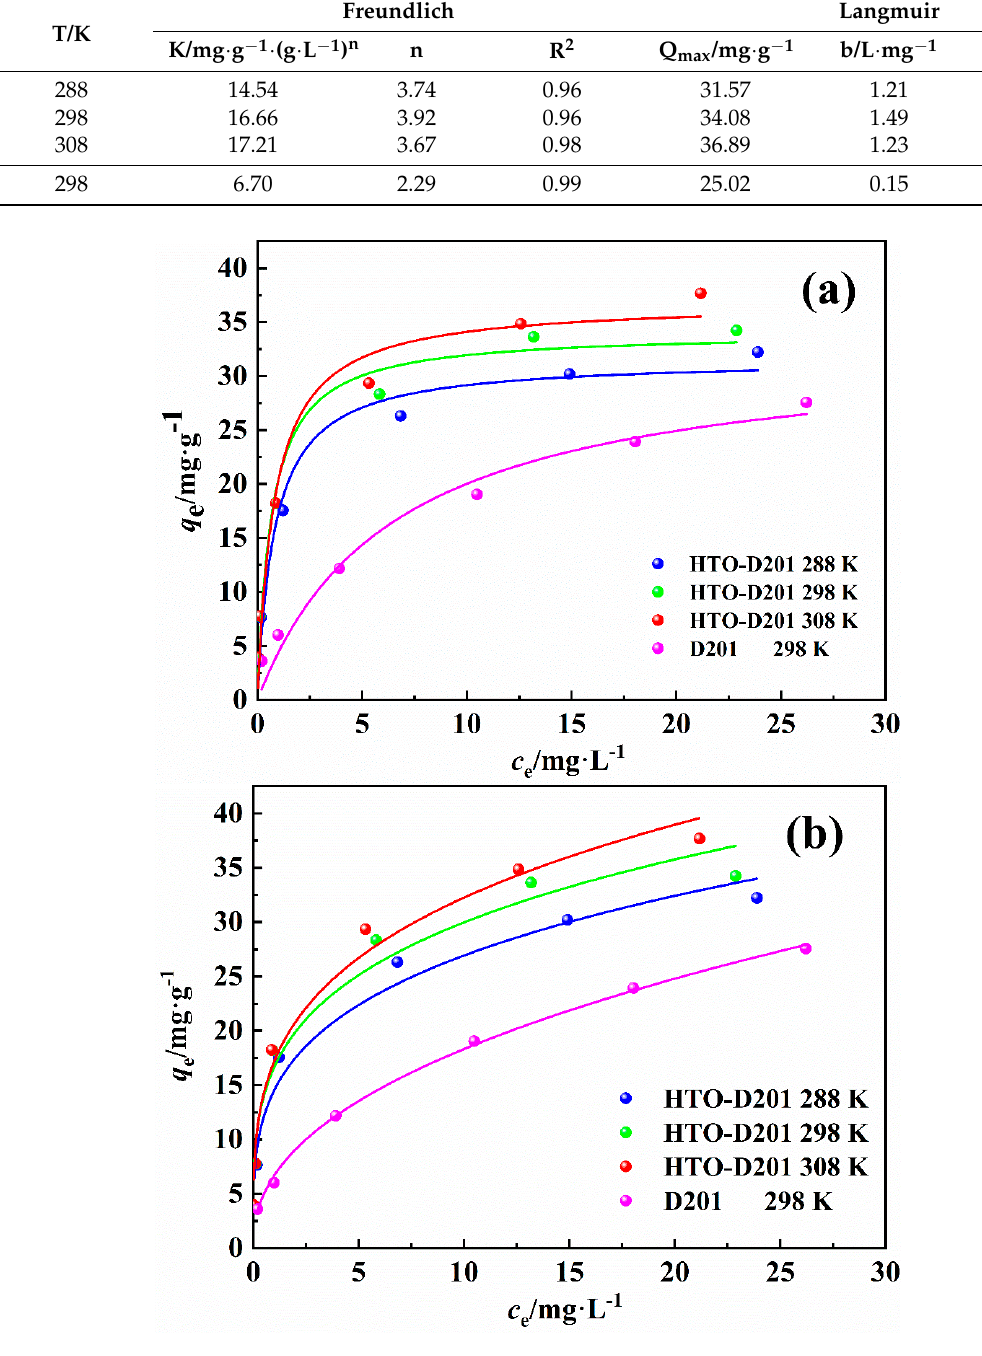
Figure 5. ( a ) Langmuir adsorption isotherm of HTO -D201; ( b ) Freundlich adsorption isotherm of HTO -D201. Table 2. Fitting parameters of Freundlich and Langmuir model for phosphate adsorption by HTO - Table 3. Thermodynamic parameters of phosphate adsorption on